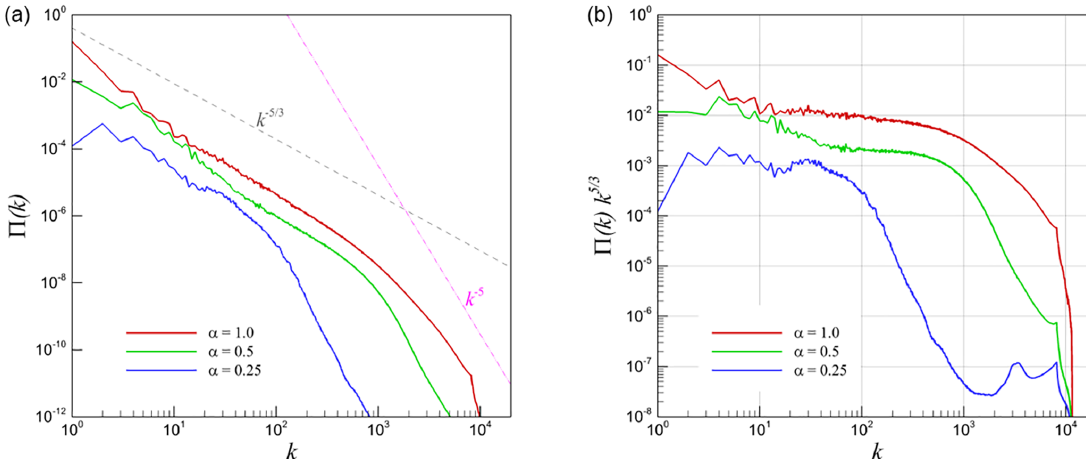
Figure 20. Angle-averaged pressure power spectra for 2-D KHI turbulence (a) and its compensated form (b) .